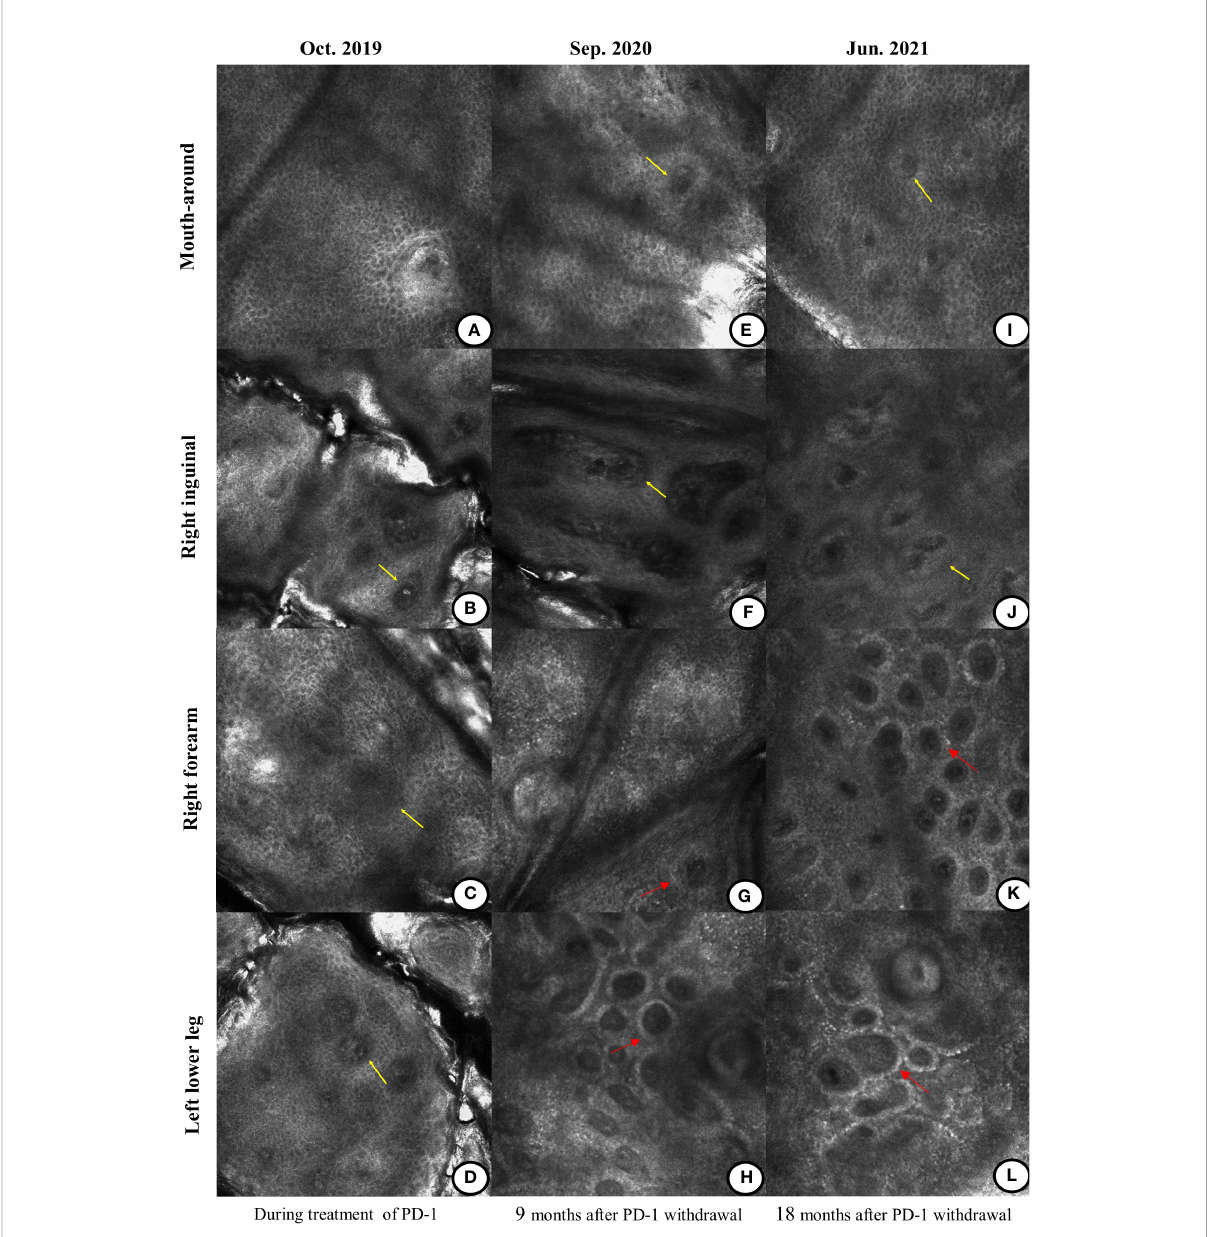
FIGURE 3 Differences in the re fl ectance confocal microscopy (RCM) images during and after the treatment of the anti-PD-1 antibody. (A – D) During the treatment of immunotherapy, the RCM images displayed the absence of pigment rings in the basal cell layer of the mouth-around, right inguinal region, right forearm, and left lower leg (yellow arrow). (E – H) Nine months after immunotherapy was discontinued, there was still no pigment ring on the mouth-around and right inguinal region (yellow arrow). Pigment rings gradually appeared on the right forearm and the left lower leg (red arrow). (I – L) Eighteen months after the immunotherapy withdrawal, there were no pigment rings in the mouth-around and right inguinal region (yellow arrow). But on the right forearm and left lower leg, the pigment rings became brighter (red